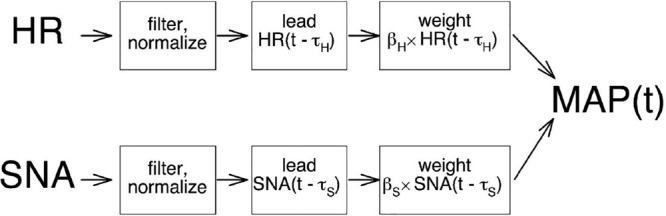
Dual input model. Ascribing differential weighing to waveform variabilities successively follows filtering and normalizing heart rate (HR) and muscle sympathetic nerve activity (SNA) and arithmetic summation to generate estimations of dynamic mean arterial pressure (MAP). Modified with permission from Myers et al. (2001).